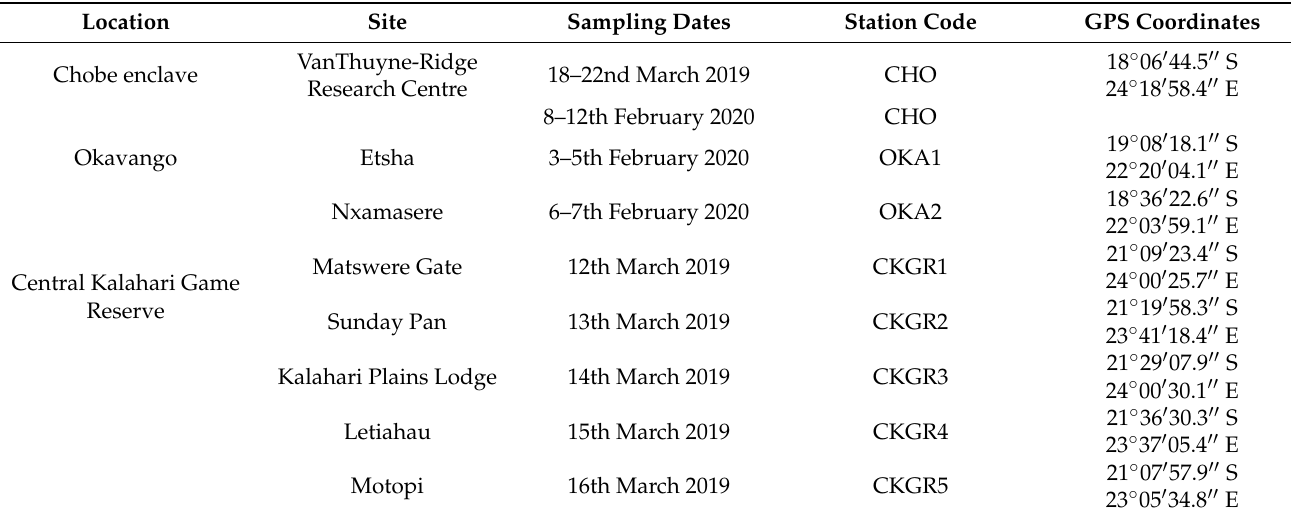
Table 2. Locations and mosquito sampling dates across areas of touristic destinations in Botswana between March 2019